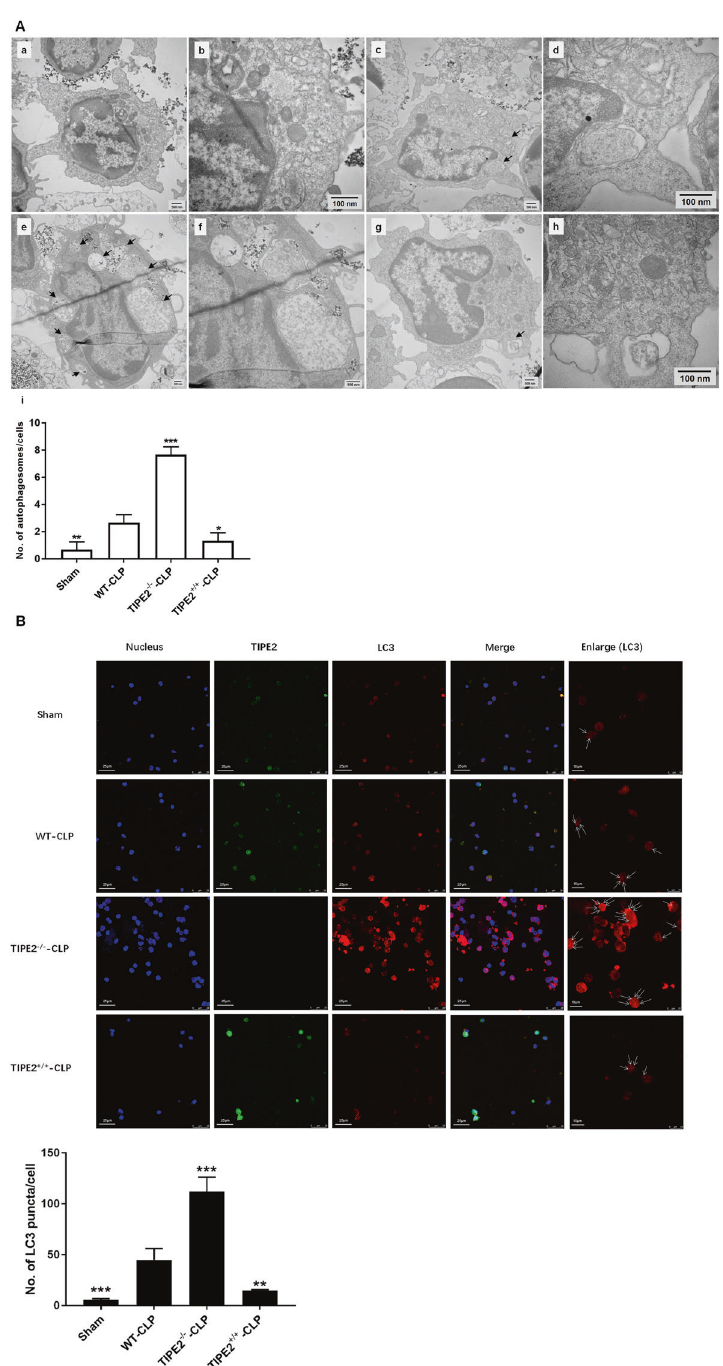
Fig. 5 Inhibitory effect of TIPE2 on the formation of autophagosomes in DCs of CLP mice. A Transmission electron microscope was used to determine the autophagosomes in DCs in the four groups (a, b: the sham group; c, d: the WT-CLP group; e, f: the TIPE2 − / − -CLP group; g, h: the TIPE2 + / + -CLP group; i: histogram of the number of autophagosomes per cell; a, c, e, g, scale bar = 500 nm; b, d, f, h, scale bar = 100 nm), arrows indicated autophagosomes. B Laser-scanning confocal microscopy was used to observe the puncta of LC3. It is shown by anti-TIPE2 antibodies (green) and LC3 (red) using immuno fl uorescence and confocal microscopy (×600, scale bar = 25 μ m; ×1200, scale bar = 10 μ m). In addition, cell nuclei were stained blue by dihydrochloride (DAPI). Data of three independent experiments are represented as mean ± SD ( n = 6 in each group). Statistical signi fi cances: compared with the WT-CLP group, * P < 0.05, ** P < 0.01, *** P < 0.001.